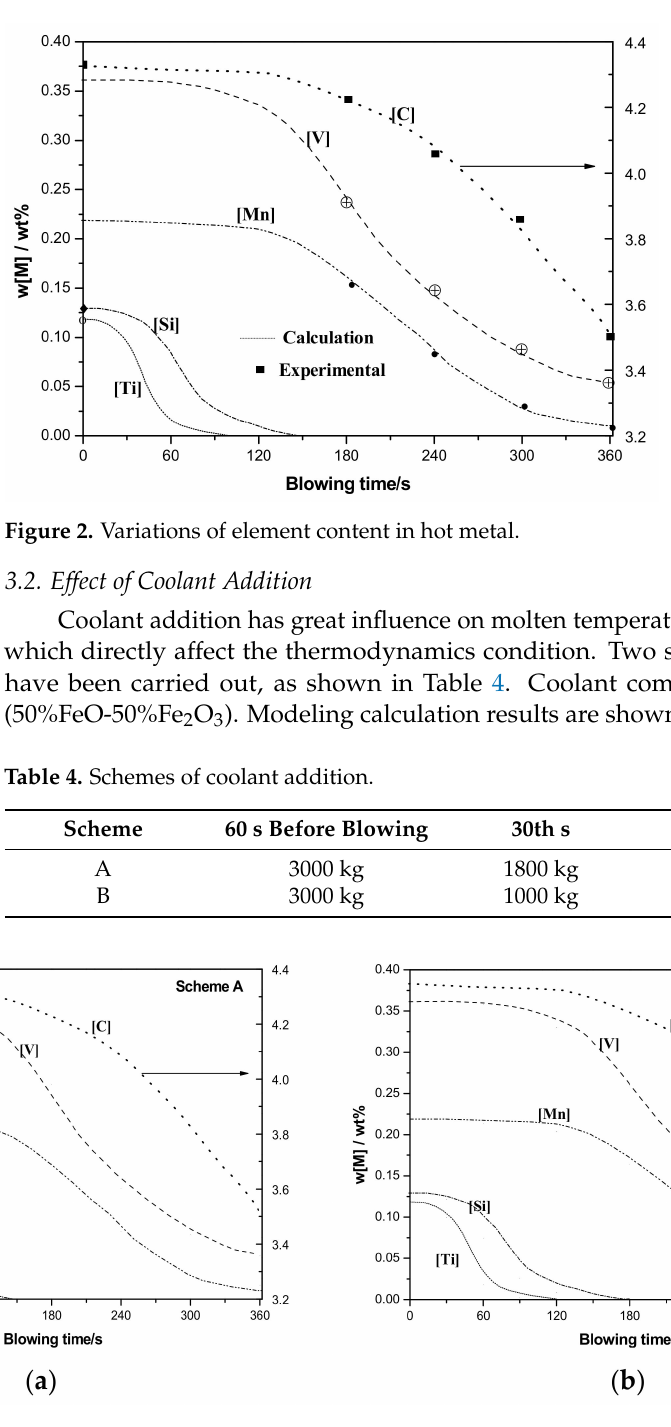
Figure 3. Effect of coolant addition on vanadium extraction refining. ( a ) Scheme A ( b ) Scheme B. Compared with Scheme A, not enough coolant has been added in Scheme B. This leads to lower (FeO) content in slag, which is unfavorable for refining reactions, and also leads to higher molten pool temperature that prevents the achievement of good thermodynamics to ensure [V] removal prior to [C] oxidation [15,16]. Thus, deep removal of [Ti] and [Si] have been delayed till about 180 s. Residual vanadium [V] have increased from 0.06 to 0.10%, and carbon content in semi-steel decreased from 3.5 to